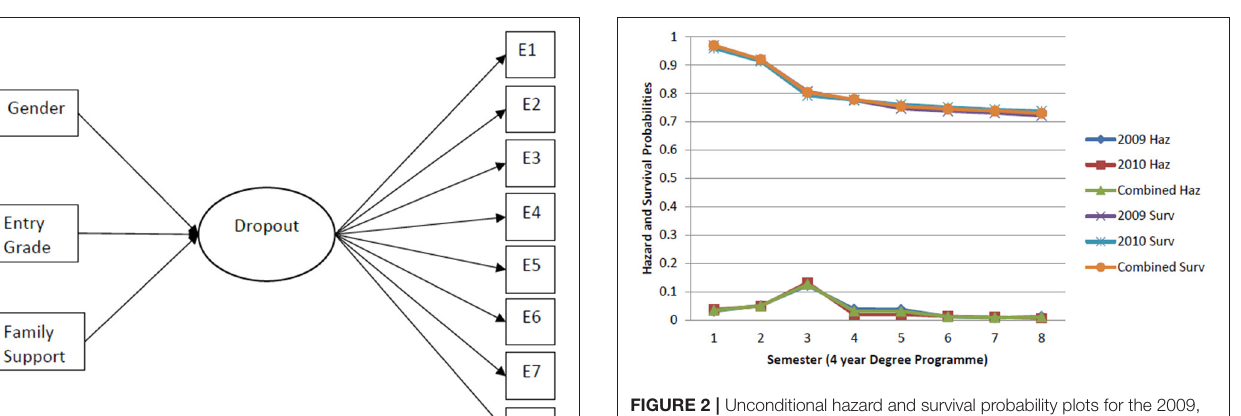
FIGURE 2 | Unconditional hazard and survival probability plots for the 2009, 2010, and combined cohorts.